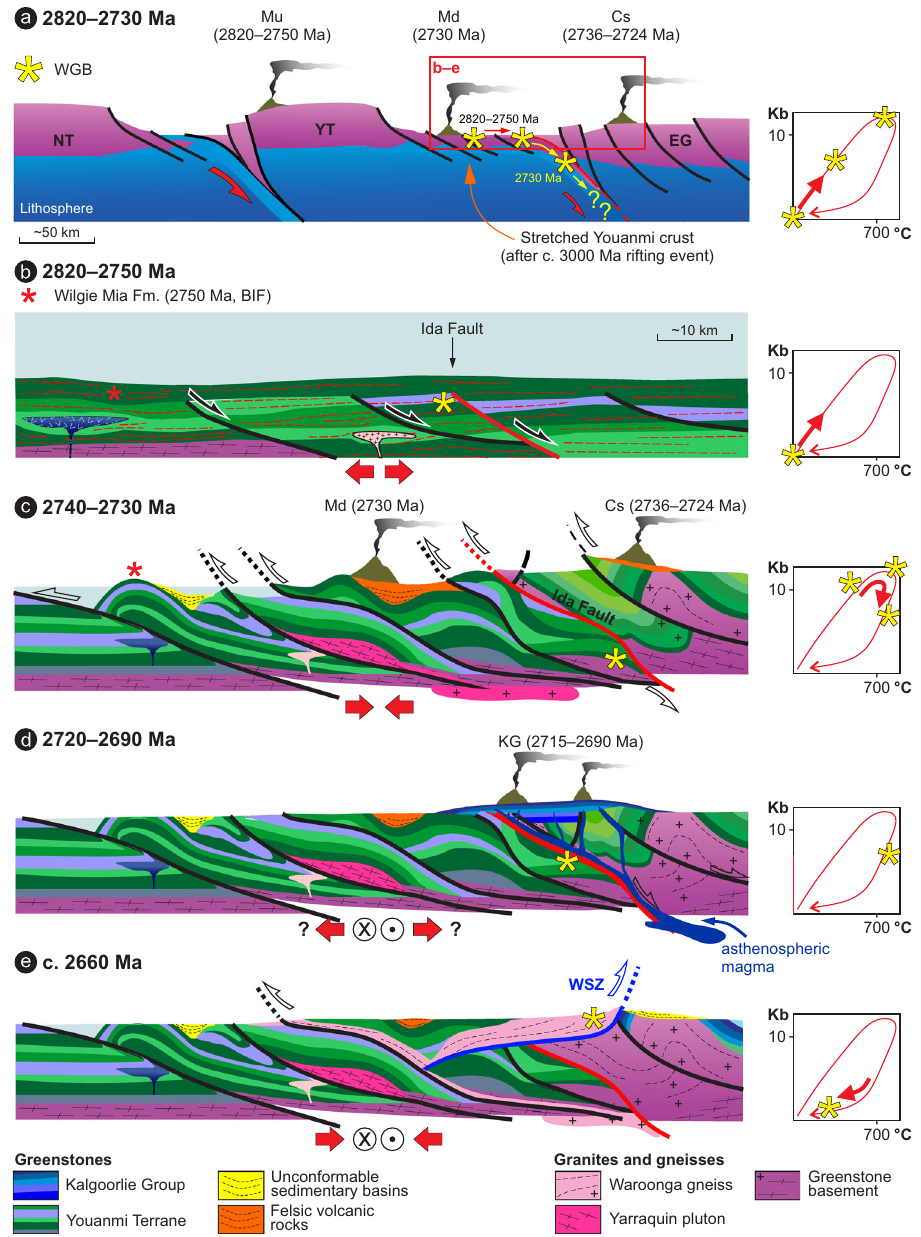
Fig. 8 | Tectonomagmatic evolution of the Waroonga greenstone belt (WGB) andtheYilgarnlithosphere. Cartoonoutliningthetectonomagmaticevolutionof the WGB and the Yilgarnlithosphere in the Meso- to Neoarchean. Note the change of scale from ( a ) to ( b ). a Long-term plate con fi guration characterized by the convergence between the Narryer (NT) and the Youanmi-Eastern gold fi elds ter- ranes (YT and EG, respectively). Volcanism with an arc signature occurred in the Murchison 41 (Mu),Marda 63 (Md)andCosmos 61 (Cs)areas. b Thepre-orogenicperiod (until c.2750 Ma 40 ) re fl ects the accumulation of a thick greenstone pile dominated by ma fi c – ultrama fi c volcanic rocks interlayered with BIFs, devoid of any clastic input 40 . The WGB developed at c. 2820Ma, in the vicinity of the proto-Ida Fault. c Synmagmatic shearing along large-scale, east-dipping contractional structures,